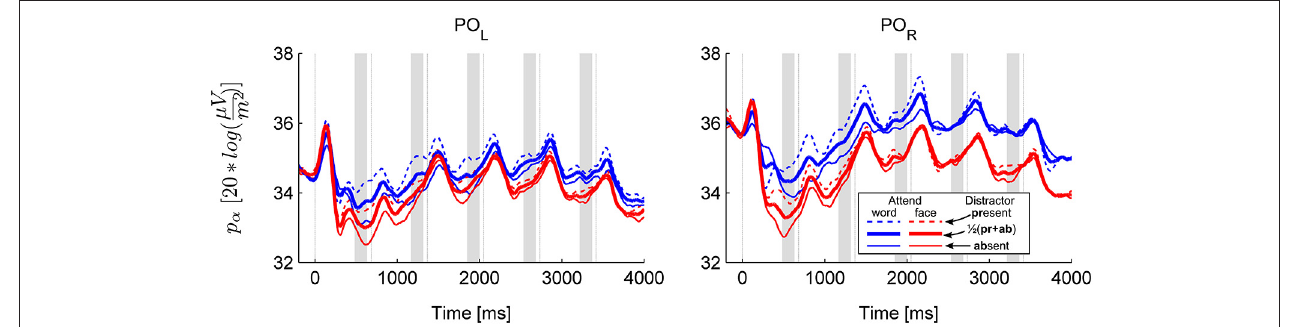
In addition, the thick lines show the marginal means for the main effect of category. Thin vertical lines are at the times of stimulus onsets (S1–S6), shaded areas depict pre-stimulus time windows of interest where anticipatory activity was assessed.